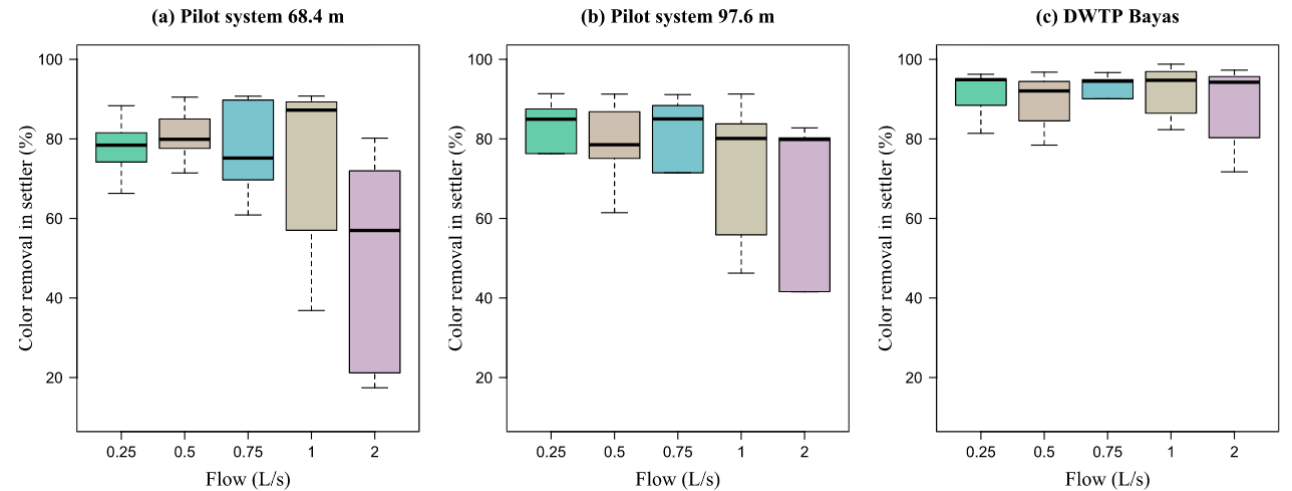
Figure 8. Color removal efficiency in the settler: ( a ) With HTF of 68.4 m, ( b ) with HTF of 97.6 m, and ( c ) in the filter of the DWTP “Bayas”. The bluish-green boxes correspond to a flow of 0.25 L/s, the brown boxes correspond to a flow of 0.5 L/s, the turquoise boxes correspond to a flow of 0.75 L/s, the beige boxes correspond to a flow rate of 1.0 L/s, purple boxes correspond to a flow rate of 2.0 L/s. At flow rates of 0.25, 0.5, 0.75, and 1 L/s, the color RE was similar using the two HTF lengths. However, for the 2 L/s flow rate, the RE was higher when a length of 97.6 m